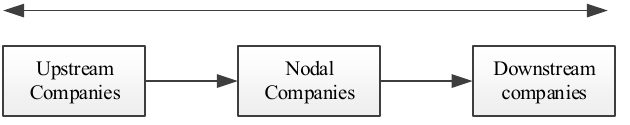
Figure 1. General conceptual model of construction supply chain.